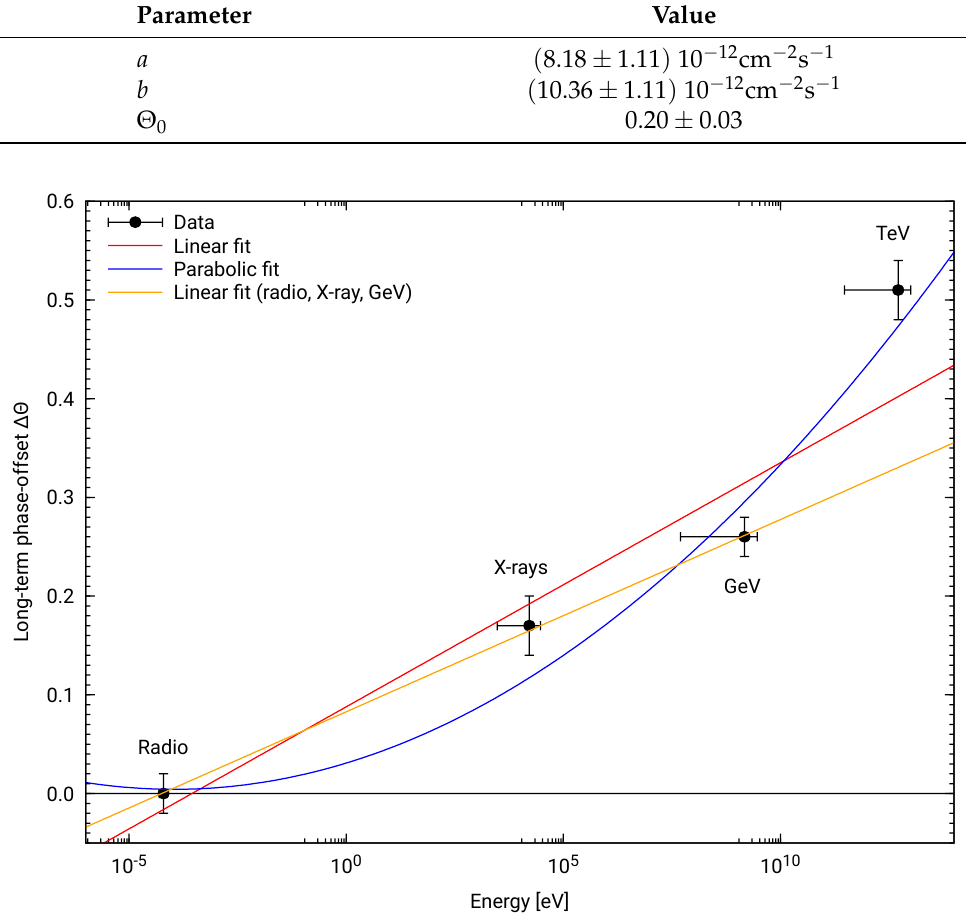
Figure 2. Phase − offset of the long-term modulation of LS I +61°303 as a function of the energy of the observed emission. Vertical error bars represent the 1 σ uncertainties of the determined phase-offset. Horizontal error bars show the energy range of the data taken to determine that value. We define the phase of the long-term modulation as ∆Θ = Θ − Θ radio . The solid curves are phenomenological fits to the data, as indicated by the line colors and explained in Section